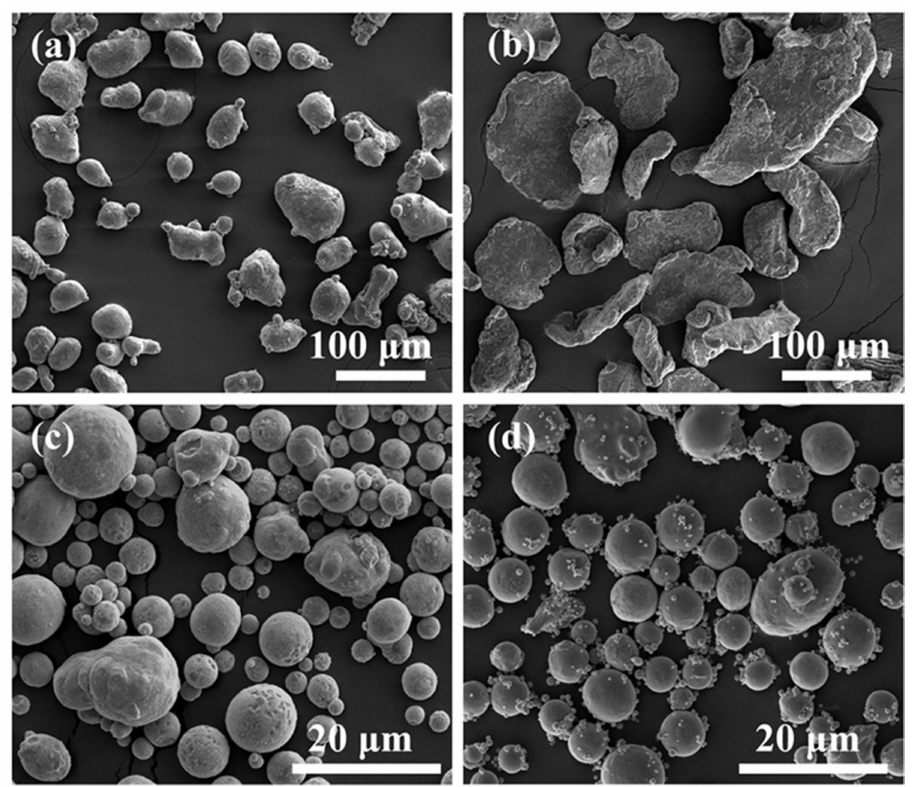
Figure 1. Scanning electron microscope (SEM) micrographs of the original powder ( a ) Al, ( b ) Mg, ( c ) Zn and ( d ) Cu